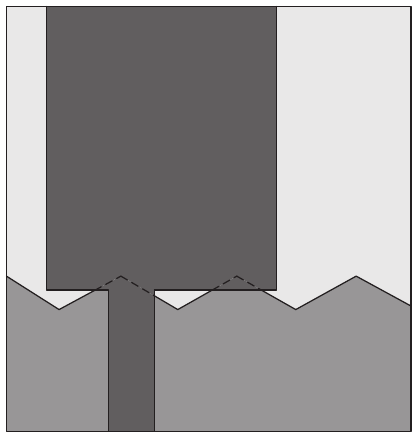
Figure 21: A monopole antenna making use of a zig-zag shaping of the upper edge of the ground plane [76]. The adopted zig-zag profile allows performing a more effective electromagnetic coupling between the feeding line and the monopole in a more extended frequency band. Dark gray upper metal face, medium gray bottom metal face, and light gray dielectric